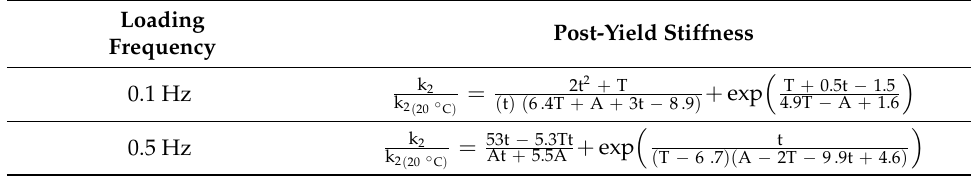
Table 6. The proposed empirical expressions for LRB’s post-yield stiffness at low ambient